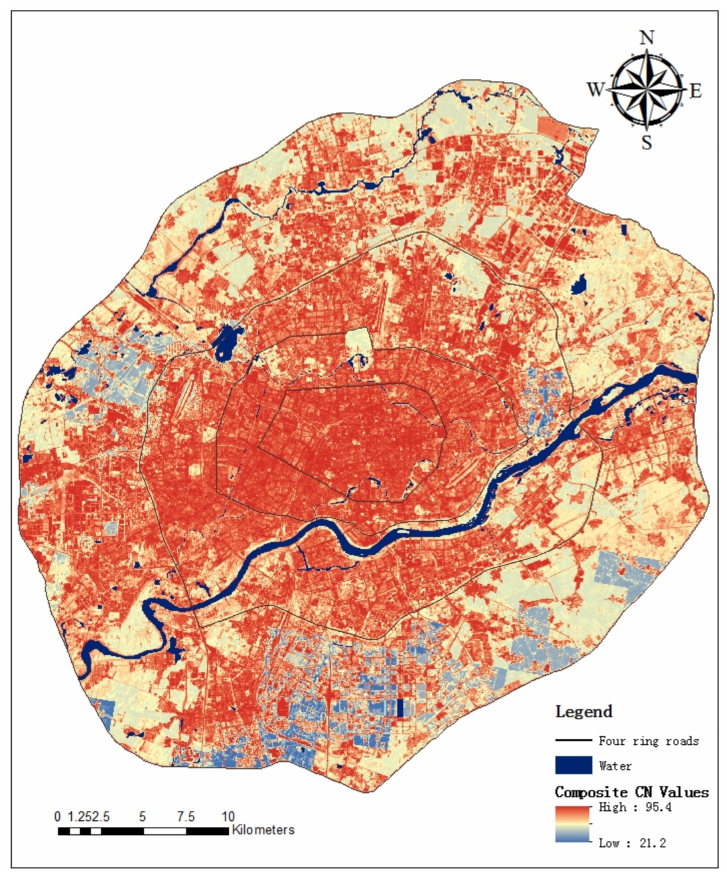
Figure 2. Composite CN values of Shenyang urban area in 2015 under AMC-I